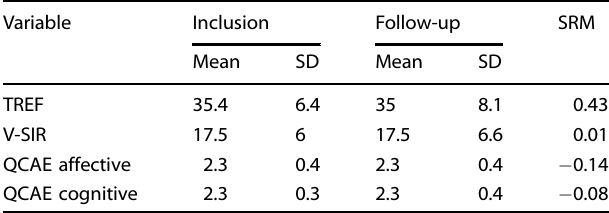
Table 3. Social cognitive performances at inclusion and follow-up and standardized responses means in individuals who completed both visits.